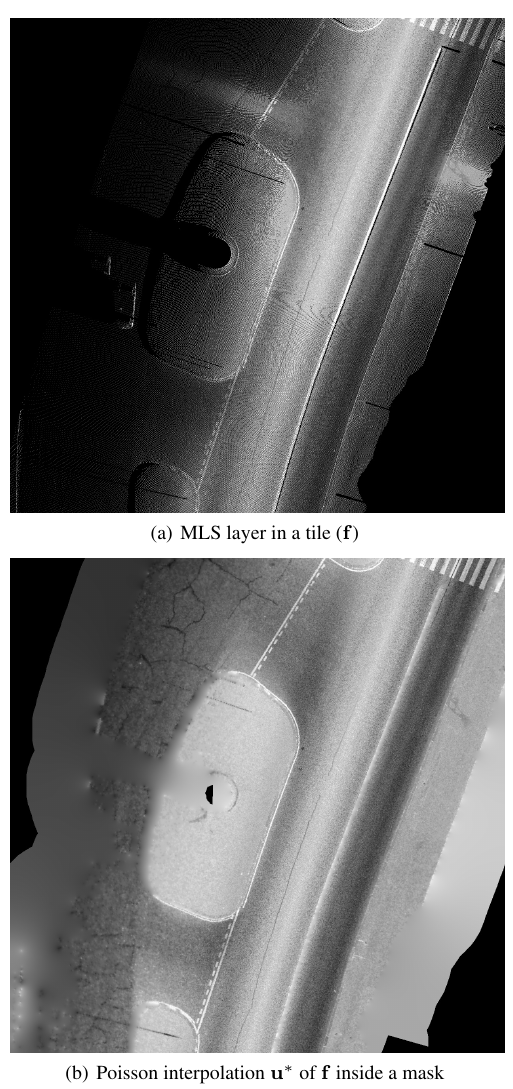
Figure 4: Illustration of Poisson interpolation on the reflectance